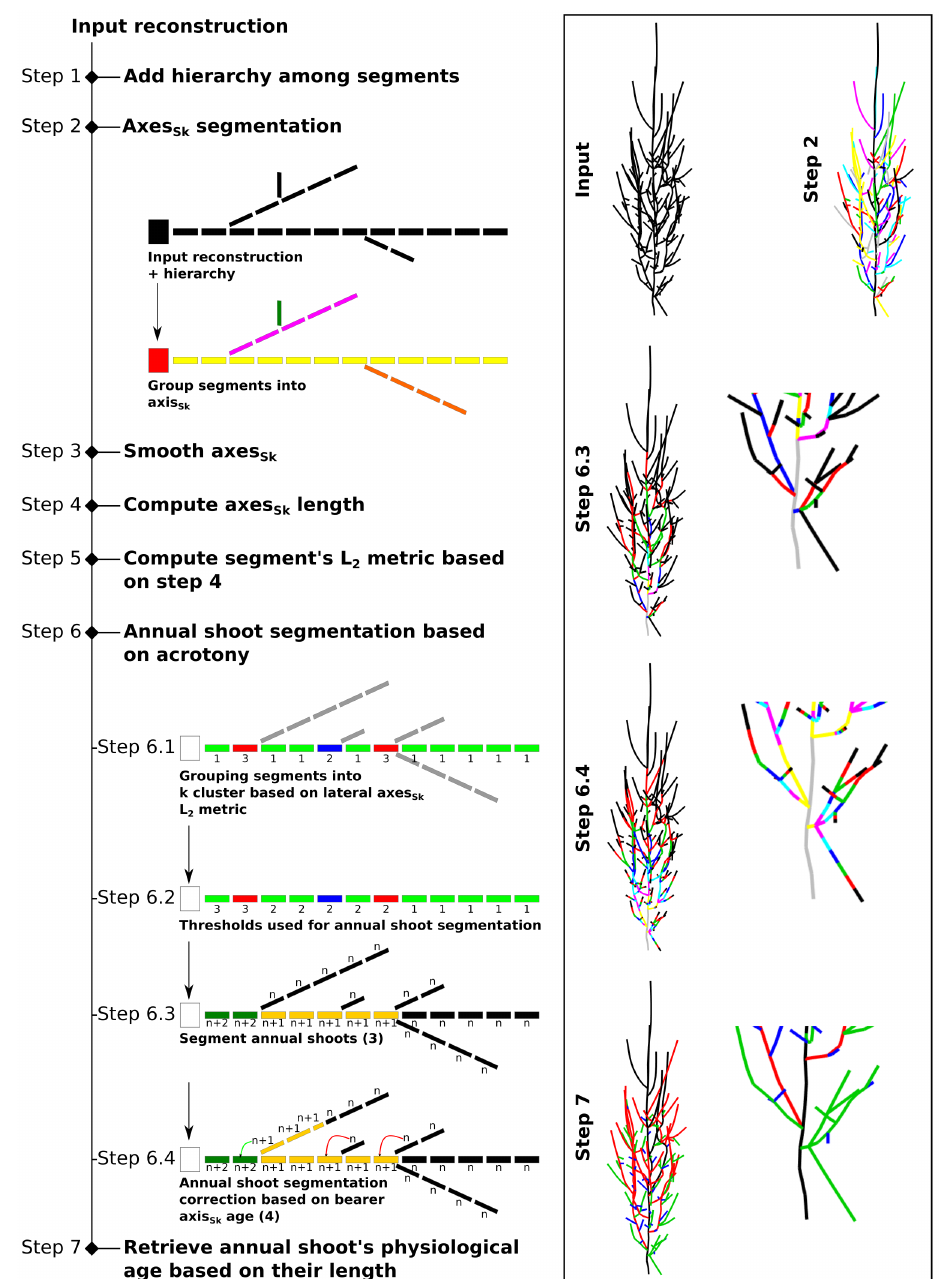
Figure 2. Illustration of the entire workflow (seven steps) involved in the annual shoot segmentation and physiological age classification model. On the left, a complete list of steps and illustrations of some steps and substeps of the algorithm. On the right, screen shots of the skeleton of a real tree at the end of key steps showing the entire tree and, in some cases, the detail of the tree base. In the screen shots, the colours correspond to the axis ID (step 2), the segmented annual shoots before non-branches axes correction (step 6.3), the corrected annual shoot segmentation (step 6.4), and the physiological ages (step 7, PA1 in black, PA2 in red, PA3 in green, and PA4 in blue). Note that substeps 6.1, 6.2, and 6.3 are illustrated in more detail in Figure